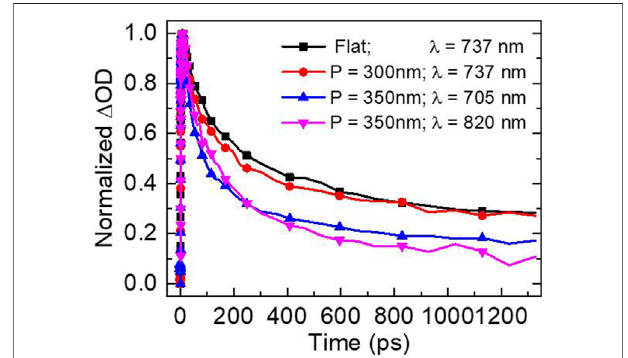
FIGURE 5 | Normalized bleaching dynamics under 560 nm resonant excitation of CH 3 NH 3 PbCl x I 3-x perovskite fi lm on a fl at Al fi lm (measured at 737 nm) and on Al nanopit arrays with periods of 350 nm (measured at the hybrid bands of 705 and 820 nm) and 300 nm (measured at the upper band of 737